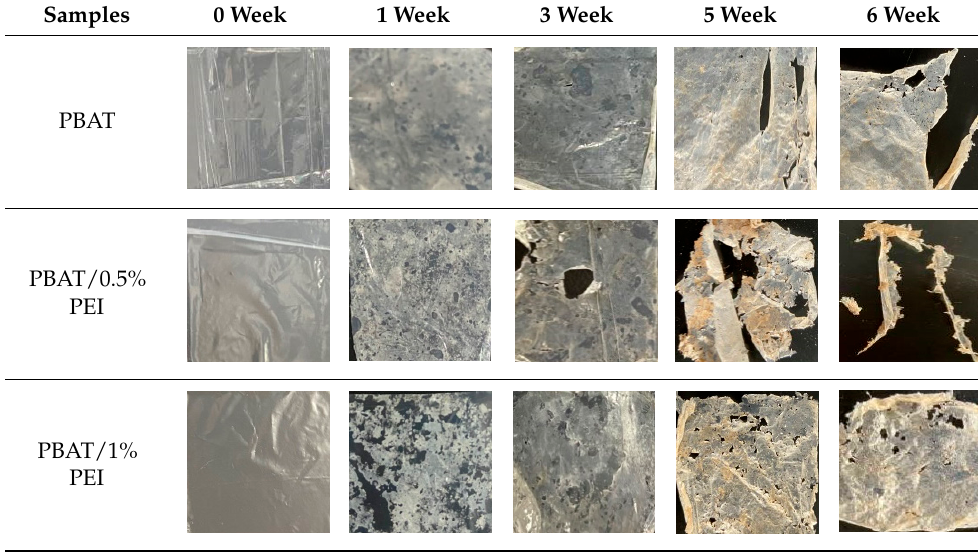
Table 9. Classification of degradation grades of films in soil surface. Samples